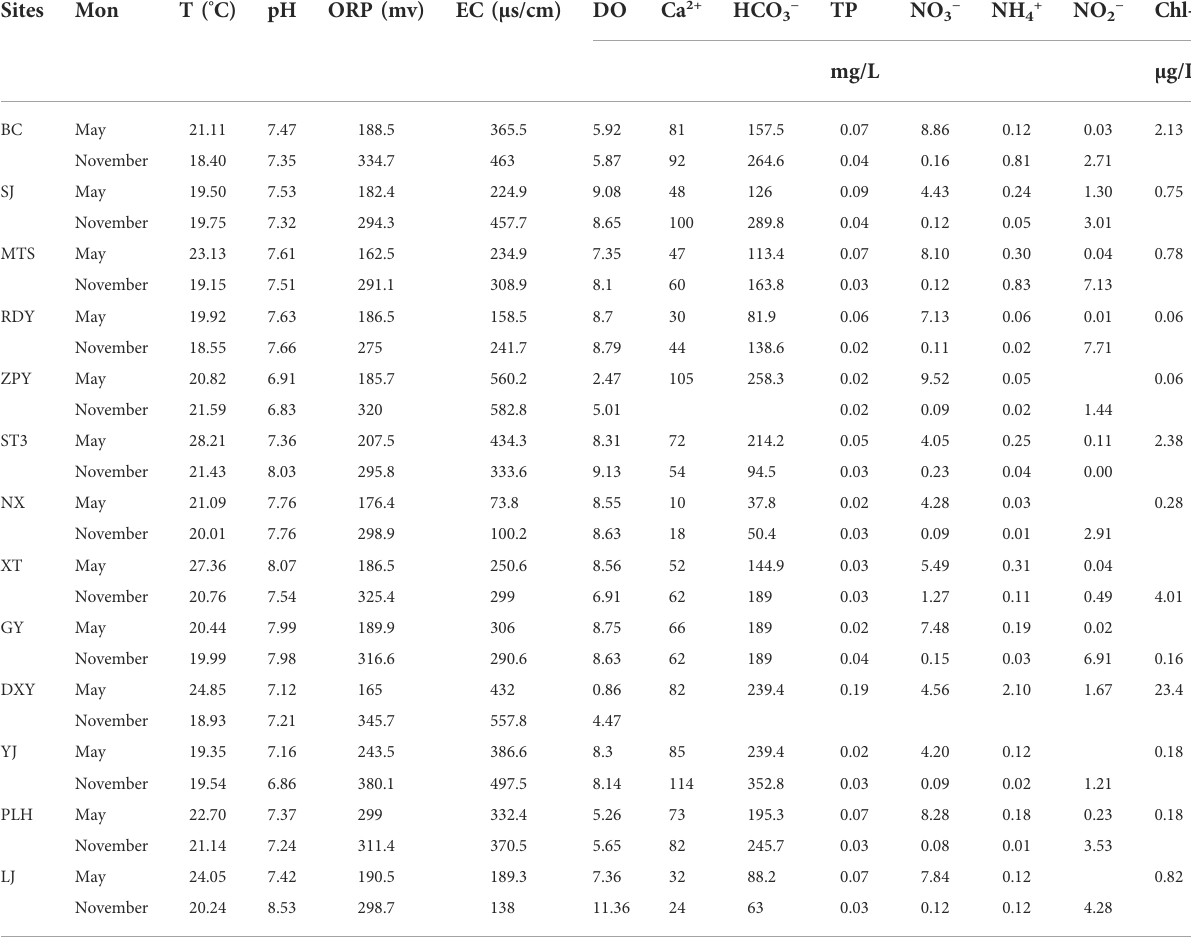
TABLE 3 Physico-chemical variables of selected wetlands. Sites Mon